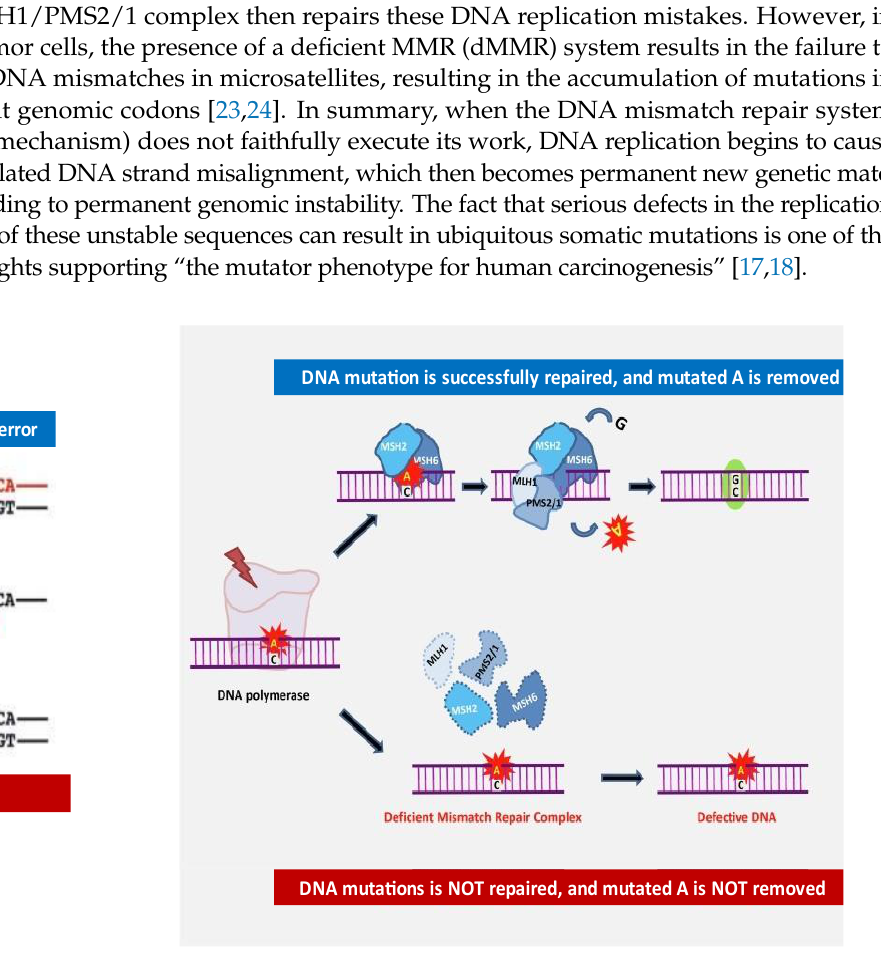
Figure 1. Development of repeat base abnormalities and role of mismatch repair in maintaining genomic fidelity. In the left side of the figure, an example of CAG repeat (microsatellite) gains and losses during DNA replication is shown. In the right side of the figure, the role of the mismatch repair complex in preventing replication errors is described. In normal cells, the DNA mismatch repair (MMR) machinery guarantees genomic fidelity by recognizing (via MSH2/MSH6 complex) and repairing (via MLH1/PMS2/1 complex) genetic mismatches generated during DNA replication. When normal G/C base pairs are mutated into A/C base pairs during DNA replication, the repair system recognizes the error (through MSH2/MSH6) and mutated A is then removed and replaced by correct C base via MLH1 and PMS1/2 machinery. Conversely, in MSI tumor cells, the presence of a deficient MMR (dMMR) system results in the failure to repair DNA mismatches in microsatellites, resulting in the accumulation of mutations in different genomic codons. So far, MLH1, MSH2, MSH6, and PMS2/1 have been found to be the main components of the MMR machinery. Modified from figure by Puliga E et al.